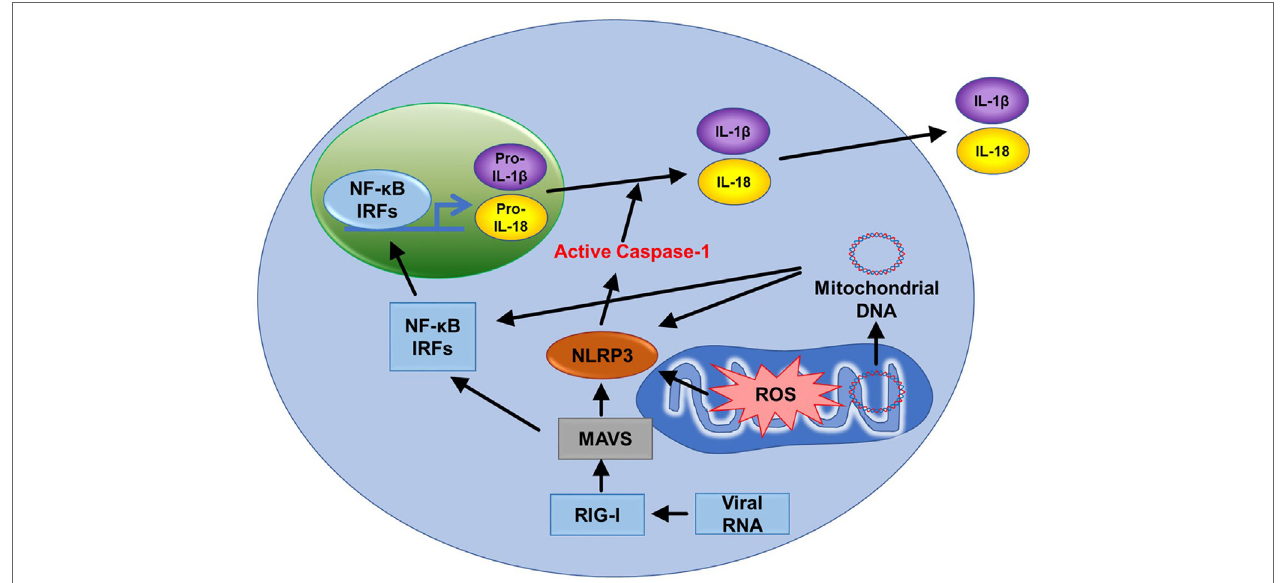
FiguRe 6 | Mitochondria related signal cascades to activate immunity. Mitochondrial antiviral signaling (MAVS) is activated by the viral RNA sensor RIG-I and promotes inflammatory and immune gene expression via transcription factor NF- κ B and IRFs. MAVS receptors can be found in the mitochondrial outer membrane. Mitochondrial ROS (mtROS) are also able to activate MAVS independently of RNA. The NLRP3 inflammasome also signals from the outer mitochondrial membrane. Like MAVS, NLRP3 also responds to mtROS and can cause mitochondrial damage that promotes the generation of additional ROS. NLRP3 drives the production of IL-1 β and IL-18. Mitochondrial DNA can also activate NLRP3. Finally, MAVS promotes oligomerization of NLRP3 at the mitochondria. Therefore, two major innate immune pathways (RIG-I/MAVS and NLRP3) are all dependent on